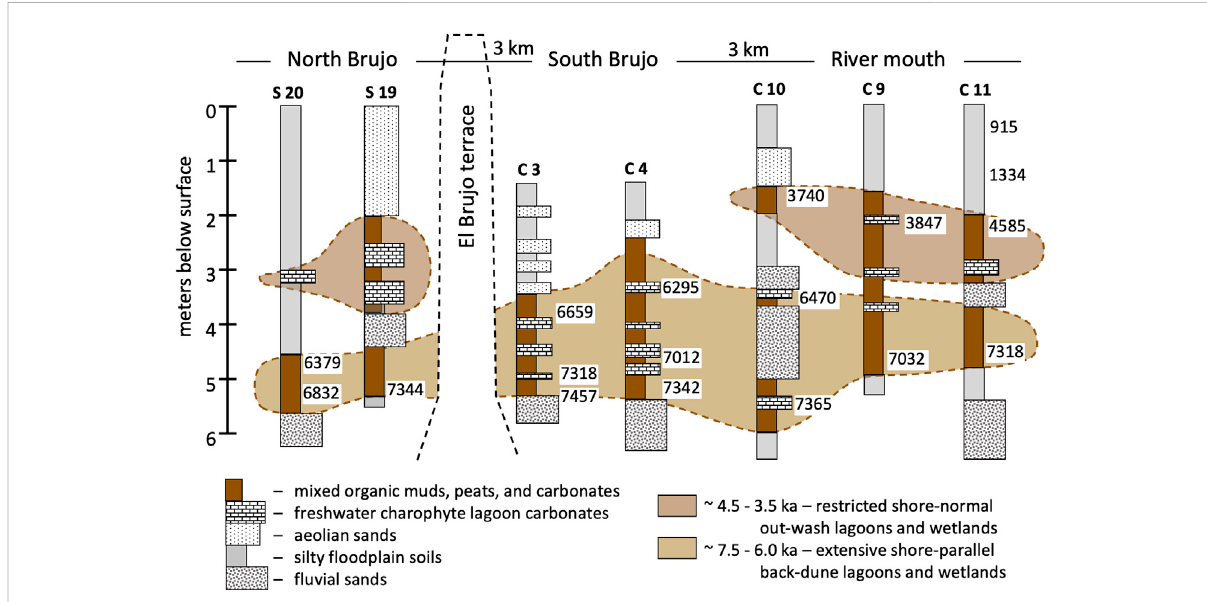
Simpli fi ed lithologs showing major sediment types and their associated depositional environments and ages (after Goodbred et al. 2017). Highlighted in brown are the organic muds, peats, and carbonate sediments that de fi ne the age and extent of paleo-lagoon and wetland systems from approximately 7,500 – 6,000 BP and 4,500 – 3,500 BP. Site locations shown in Figure 8. North Brujo refers to north of the Sangamon terrace. South Brujo refers to south of the terrace. River mouth refers to the Chicama River